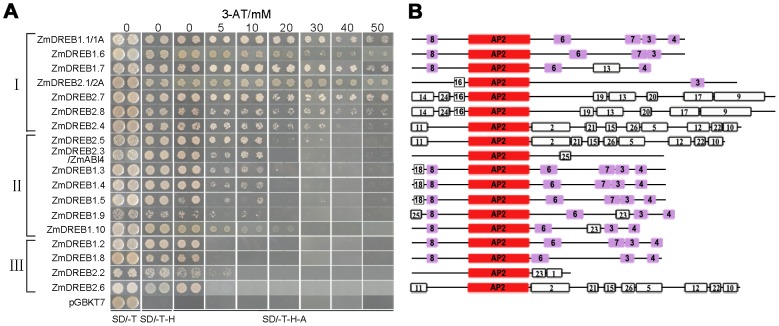
Transactivation activity assay and motif analysis of 18 ZmDREB proteins.(A) Cultures of the AH109 yeast, transformed with a plasmid containing different ZmDREB genes, were diluted and inoculated on to a synthetic dropout (SD) media without tryptophan (SD/-T), without tryptophan and histidine (SD/-T-H), or without tryptophan, histidine, and adenine (SD/-T-H-A). The culture plates were amended with different concentrations of 3-aminotriazole (3-AT). Genes were classified into one of three groups (I, II, or III) representing high, medium, or low transactivation activity, respectively. Photos were taken 2 days after inoculation for the plates without 3-AT, and 5 days after inoculation for the plates with various concentrations of 3-AT. (B) Motif analysis of ZmDREB proteins. Conserved protein motifs were identified using the SALAD database (http://salad.dna.affrc.go.jp/salad/). Different motifs were numbered from 1 to 26 and genes labeled with the same number(s) indicate that the same motif(s) was present in the different ZmDREB proteins. The conserved AP2/ERF domain is highlighted in red. Motifs labeled in purple were specific to ZmDREB1 group proteins, except that Motif 3 was also identified in the ZmDREB2.1/2A protein.